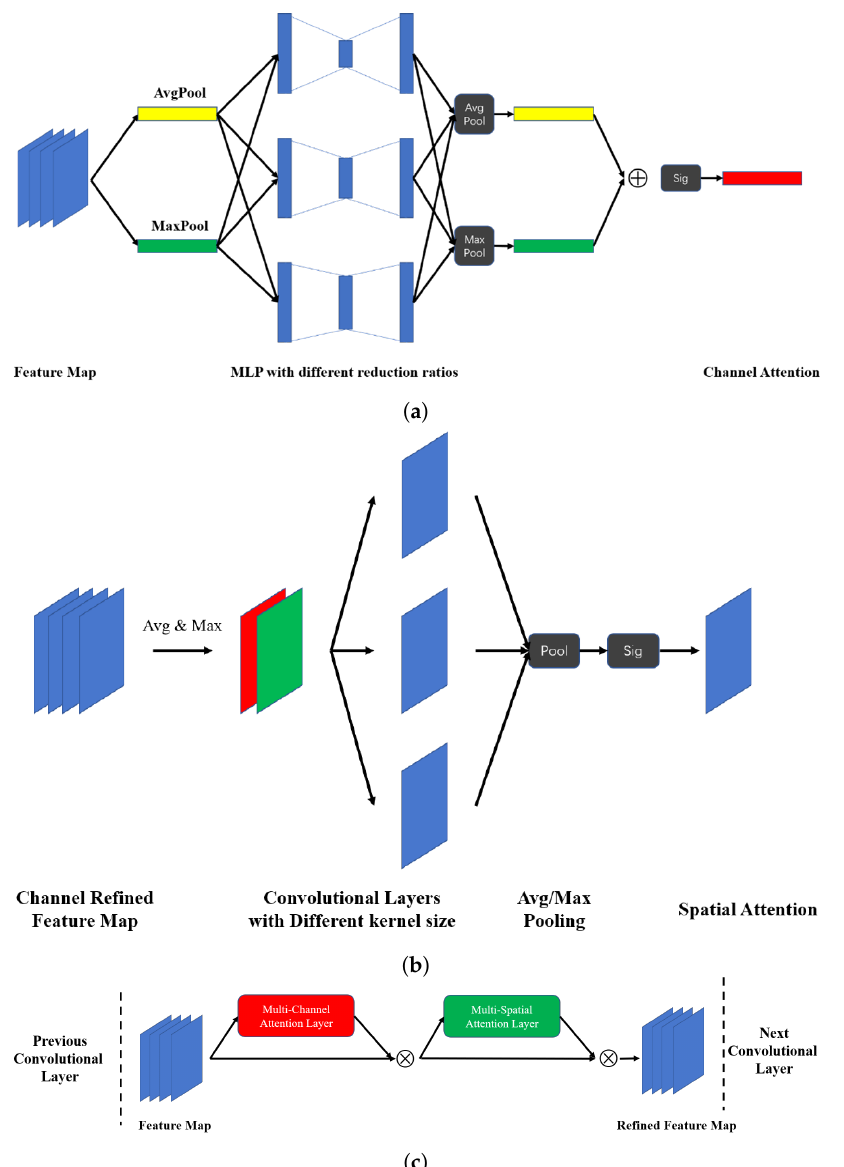
Figure 3. The proposed MCMS attention module consists of a multi-channel attention layer and a multi-spatial attention layer and can be easily plugged into any CNN backbone network with mini- mum change in the code level. ( a ) Multi-Channel Attention Layer; ( b ) Multi-Spatial Attention Layer; ( c ) MCMS attention module integrated with a convolutional layer. As shown in Figure 3b, the refined feature map F (cid:48) ∈ R C × H × W is firstly applied to produce two one-channel feature maps F S and F S that are in R 1 × H × W . These two avg max feature maps are concatenated along the channel axis as the input to multiple parallel convolutional layers with different kernel sizes. The output feature map of each con- ∈ R 1 × H × W can encode where to emphasize or suppress, where i volutional layer M i , k i is the index of convolutional layer and k i is the corresponding kernel size. Intuitively, the choice of applying different kernel sizes could potentially produce richer attention ∈ R 1 × H × W information. The output feature maps of these convolutional layers M i , k i are concatenated along the channel axis to produce a set of feature maps denoted as ] ∈ R m × H × W , where m is the number of parallel convolu- M = [ M 1, k ; M 2, k ; . . . ; M m , k m 2 1 tional layers. M then passes through an average or max pooling layer along the channel axis to produce M avg or M max in R 1 × H × W , which is followed by a sigmoid function